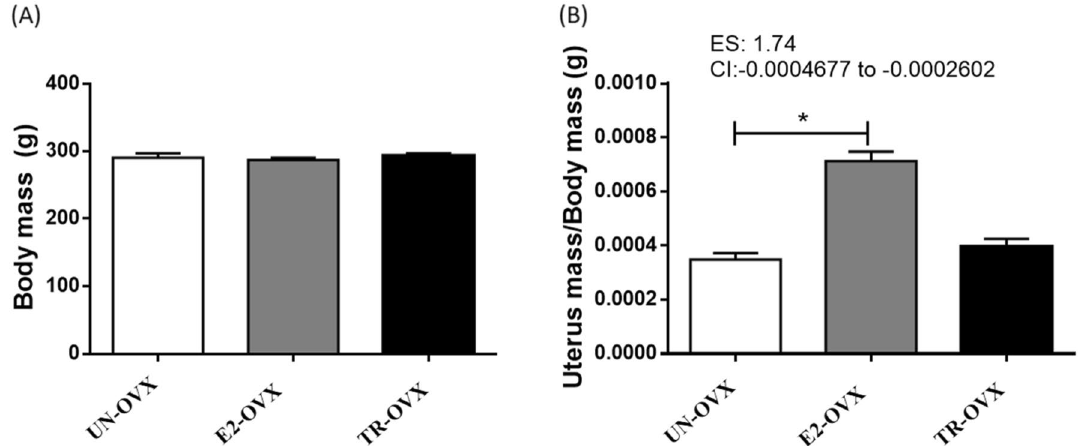
Figure 1. ( A ) Body mass and ( B ) uterus mass/body mass ratio of untrained ovariectomized rats (UN-OVX), ovariectomized rats treated with Estradiol replacement (E2-OVX), and trained ovariectomized rats (TR-OVX). N = 10 per group. Data are presented as mean ± S.E.M. 95% confidence interval (CI). Effect size (ES) *p < 0.05 (TR-OVX vs E2-OVX). One-way ANOVA followed by Dunnet posthoc test.